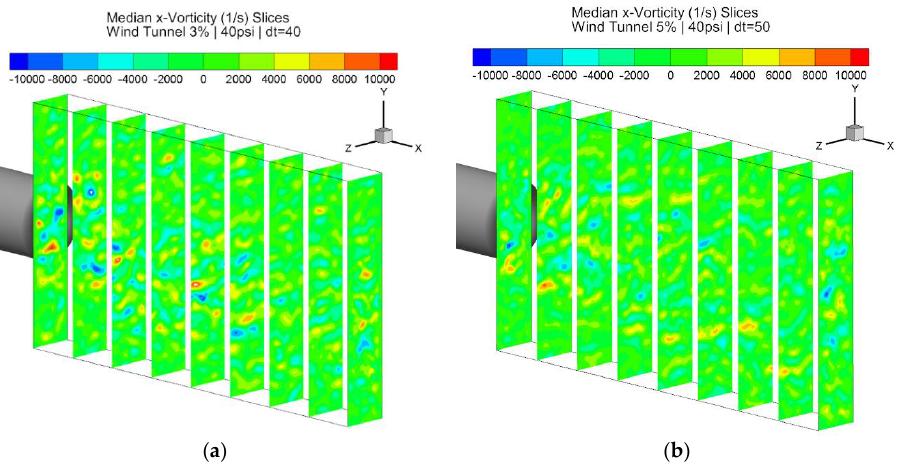
Figure 19. Instantaneous vorticity slices for 40 psi and the 3% ( a ) and 5% ( b ) freestream settings.